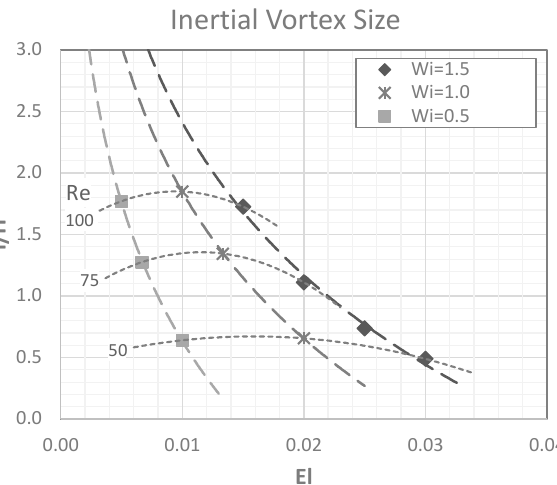
Figure 10. Non-dimensional inertial vortex length for polymer flow vs. elasticity.